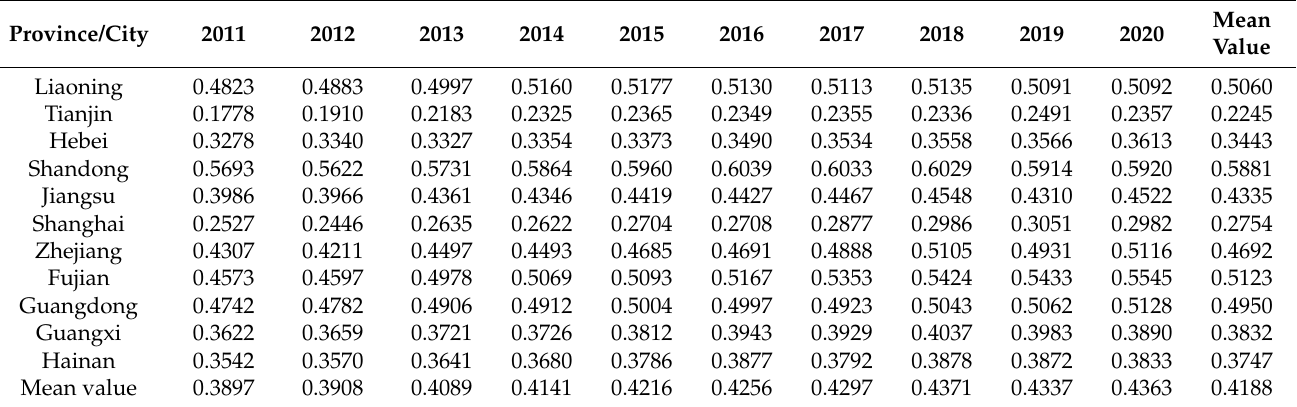
Table 5. Coordination between marine-environment quality and marine-fishery-economy quality (2011–2020).